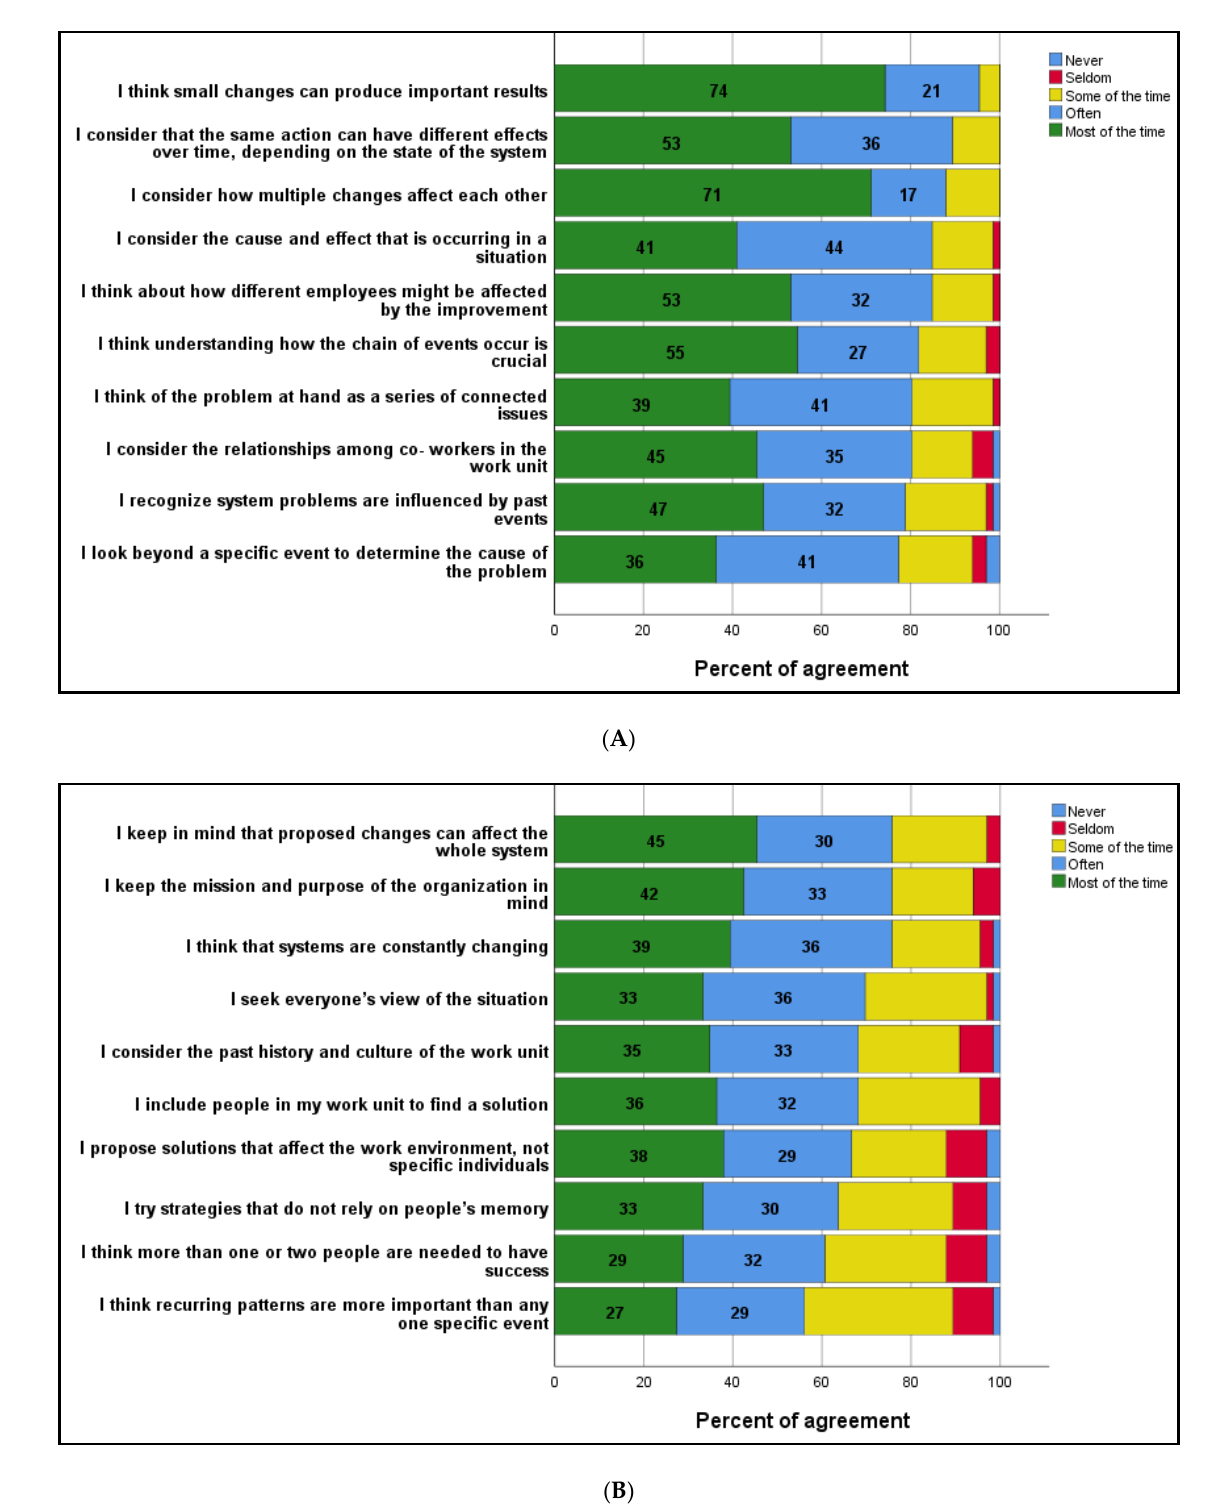
Figure 1. Students’ level of agreement with system thinking survey items. ( A ), Part 1. ( B ), Part 2. A radar chart was used to show the system thinking items that were the most ap- parent in the horror room setting. The following statements had the most agreement: “I think understanding how the chain of events occur is crucial”, “I think small changes can